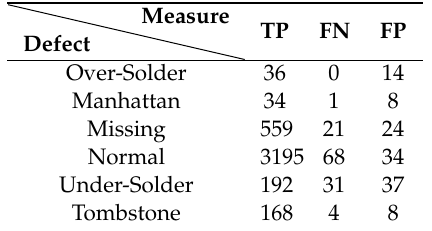
Figure A1. Confusion matrix for single-stream CNN ( left ), early-merge dual-stream CNN ( center ), late-merge dual-stream CNN ( right ). Table A1. Classification results of single-stream CNN.